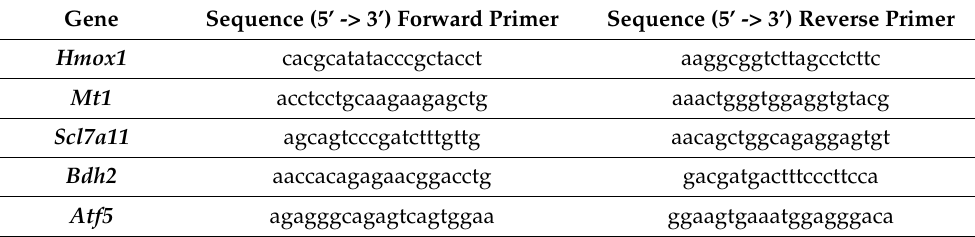
Table 2. List of primers used for RT-PCR Analysis.